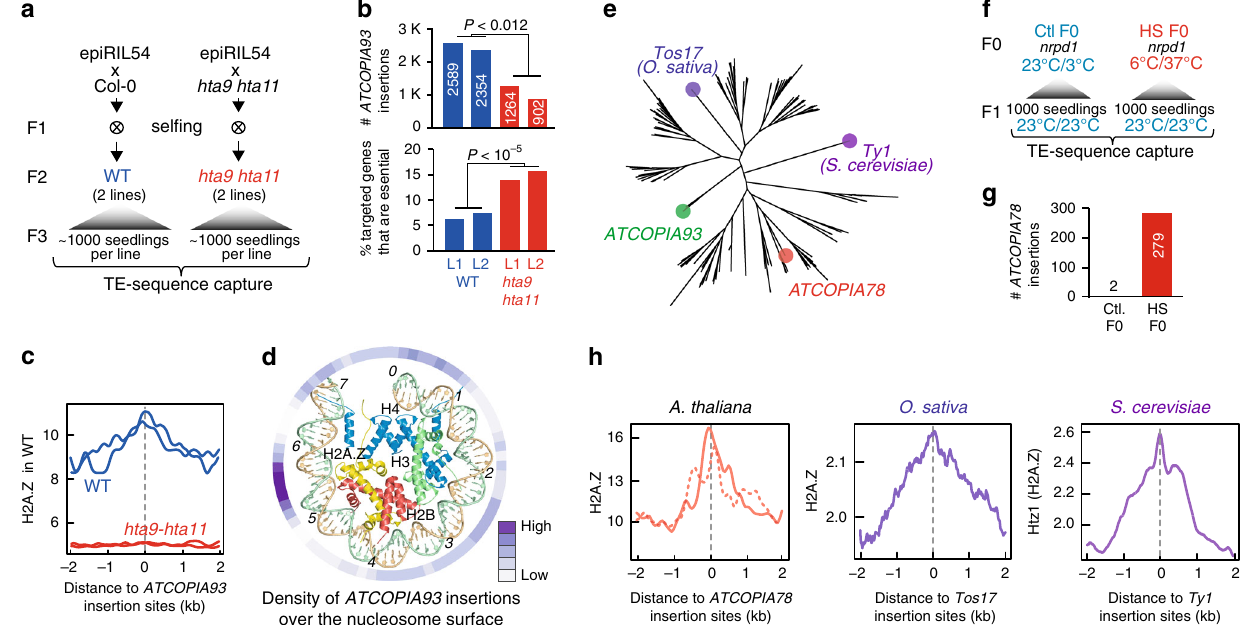
Fig. 4 H2A.Z guides the integration of Ty1/Copia retrotransposons. a Experimental strategy for determining the role of H2A.Z in the integration of ATCOPIA93 . b Number of new ATCOPIA93 insertions detected in HTA9 HTA11 and hta9 hta11 F3 seedlings (top). Fraction of essential genes among those targeted by ATCOPIA93 (bottom). Statistically signi fi cant differences were calculated using the chi-square test. c Meta-analysis of levels of H2A.Z levels around ATCOPIA93 insertion sites. d Density of ATCOPIA93 insertions over well positioned nucleosomes. e Phylogenetic analysis of Tos17 , Ty1 and 110 A. thaliana Ty1/Copia LTR-retrotransposons. f Experimental strategy for studying transposition of the heat-responsive ATCOPIA78 LTR-retrotransposon in A. thaliana . g Number of new ATCOPIA78 insertions detected in F1 seedlings of nrpd1 plants grown under control or heat-stress conditions. h Meta-analysis of A. thaliana , rice ( O. sativa ) and yeast ( S. cerevisiae ) H2A.Z levels around ATCOPIA78 , Tos17 , and Ty1 insertion sites, respectively. For A. thaliana , experimental and natural insertions are indicated by solid and dotted lines, respectively. Source data of Figure panels. b , d , g , and h are provided as a Source Data fi